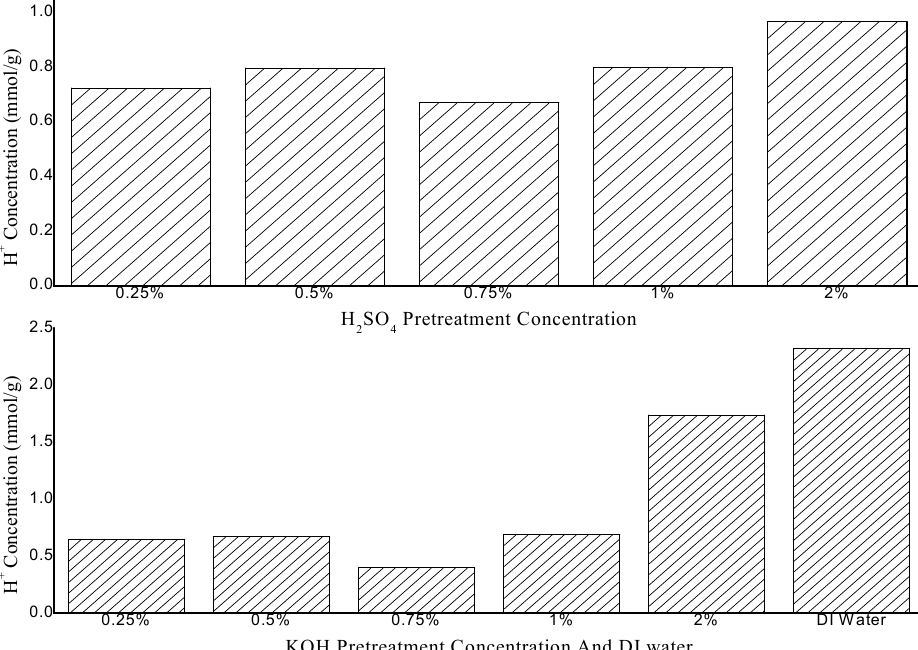
Figure 2. H + concentration of the bamboo-derived magnetic solid acid prepared by different pretreatment conditions.